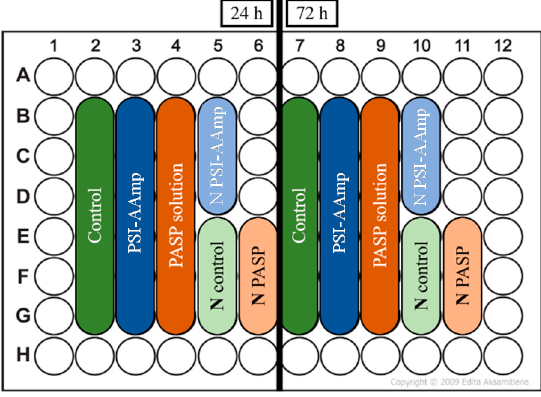
Figure 1. Sample distribution on the cell culture plate. N stands for negative control.